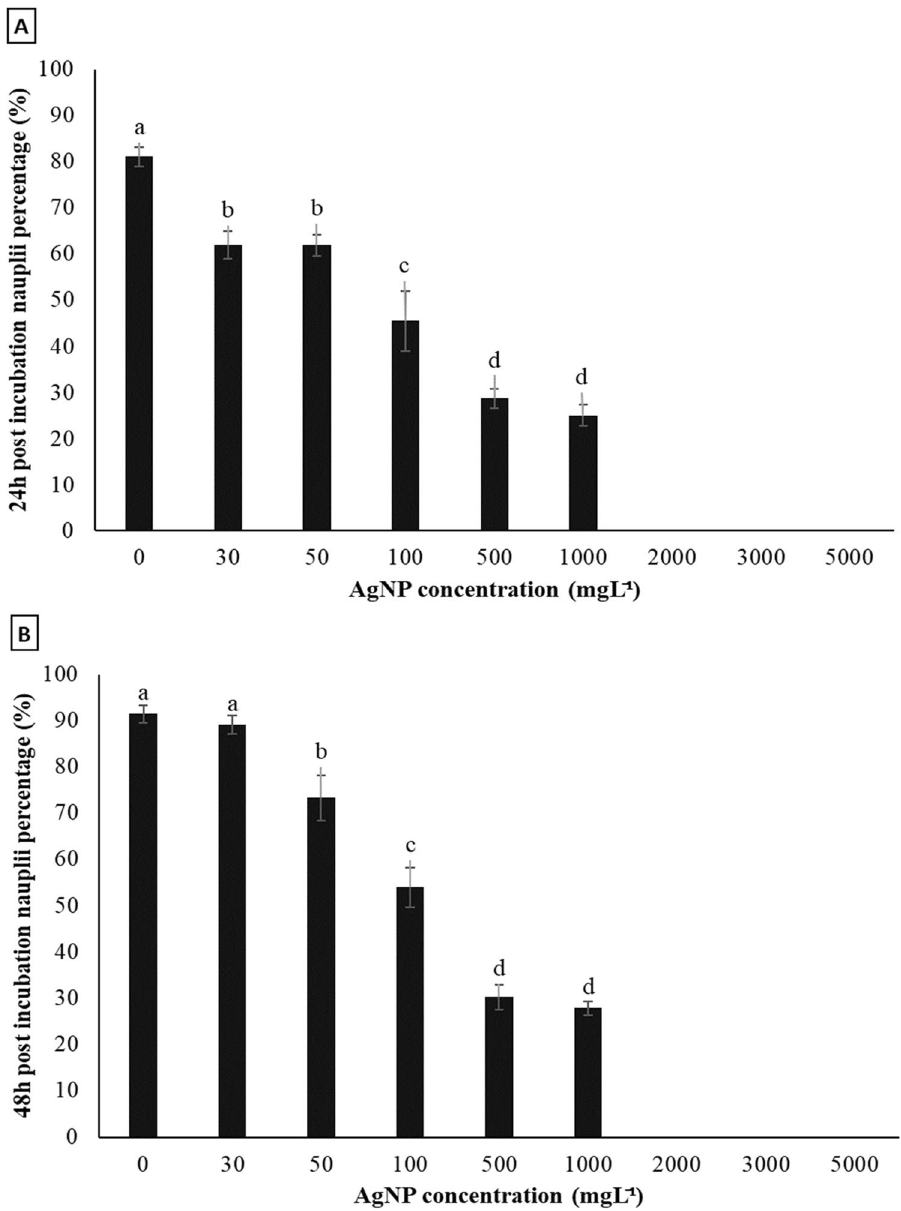
Figure 5. Effect of AgNP concentration on nauplii transformation percentage of Artemia incubated on tryptic soy agar for 24 h (a) and 48 h (b) . Values are presented as means ± S.D. (n = 10). The same letters indicate statistically insignificant differences ( p >